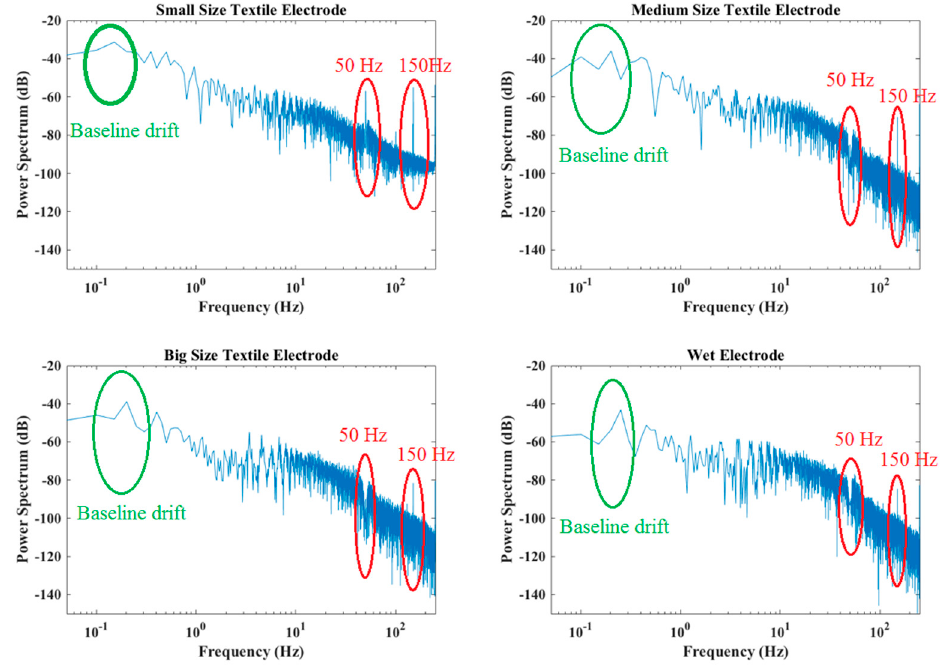
Figure 10. Power spectral density.